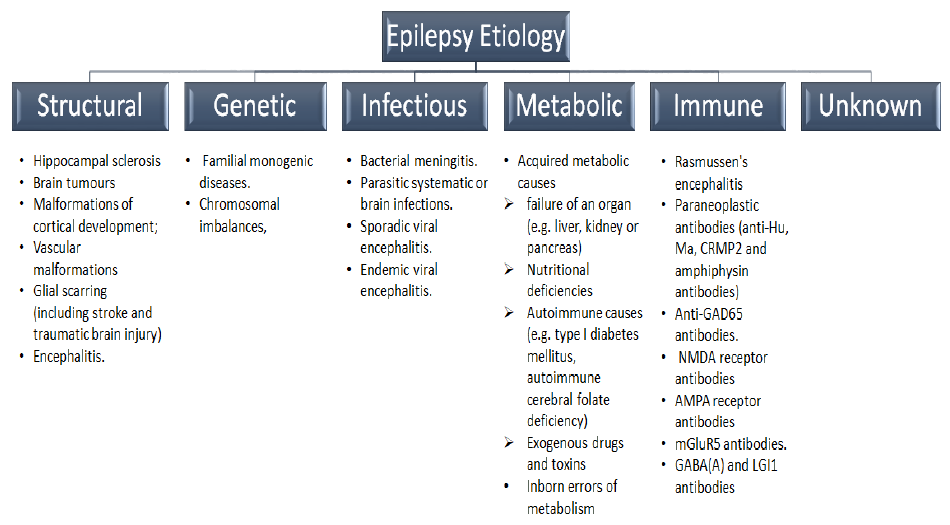
Figure 1. Etiology of epilepsies.